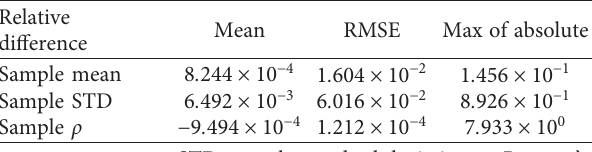
Figure 11: Eigenvalue distribution of relative covariance matrix. Blue dots show the eigenvalue distribution of transformed logarithmic relative covariance. Red dots show the eigenvalue distribution of approximated relative covariance matrix searched by nearest-SPD al- gorithm. Grey lines show the relative difference of these eigenvalues. Table 4: Independent yield samples